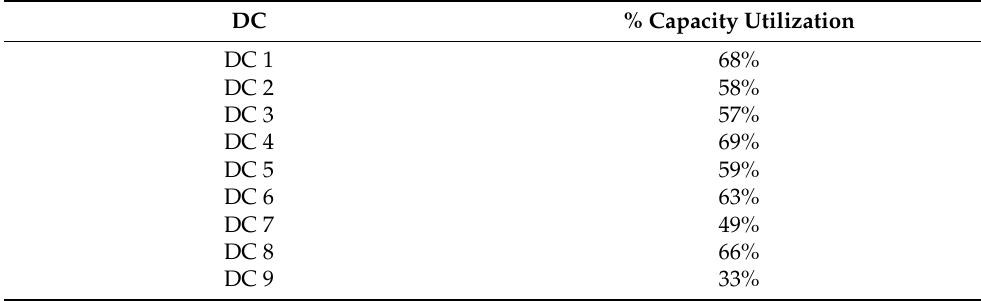
Table 6. Percentage of truck utilization by regional